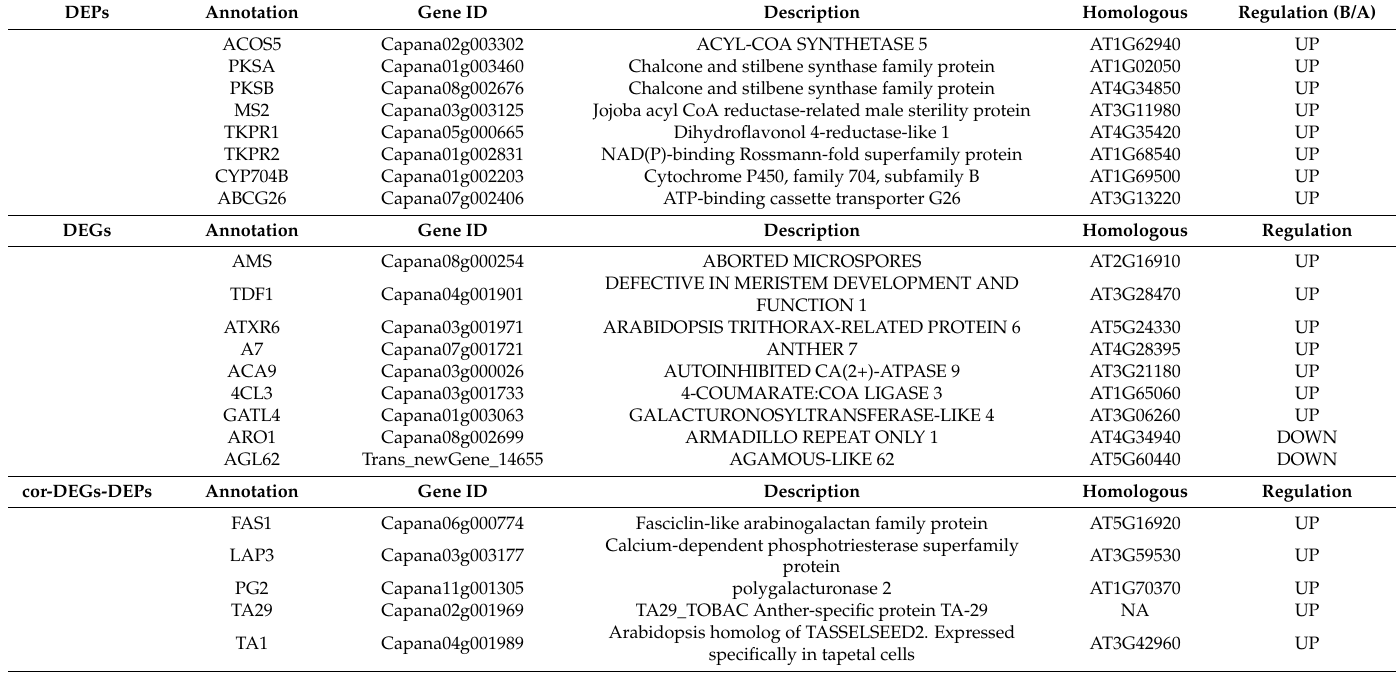
Table 1. List of DEPs and DEGs associated with anther and pollen development in